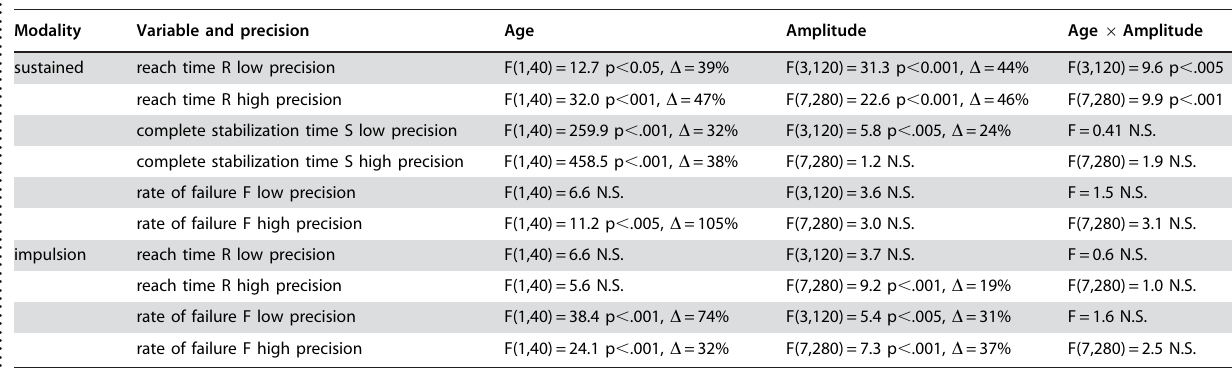
Table 2. Effects of Age and Amplitude on performance, for each condition of precision. .. ... .... ... ... .... ... ... .... ... ... .... ... ... .... ... ... .... ... ... .... ... ... .... ... ... .... ... ... .... ... ... .... ... ... .... ... ... .... ... ... .... ... ... .